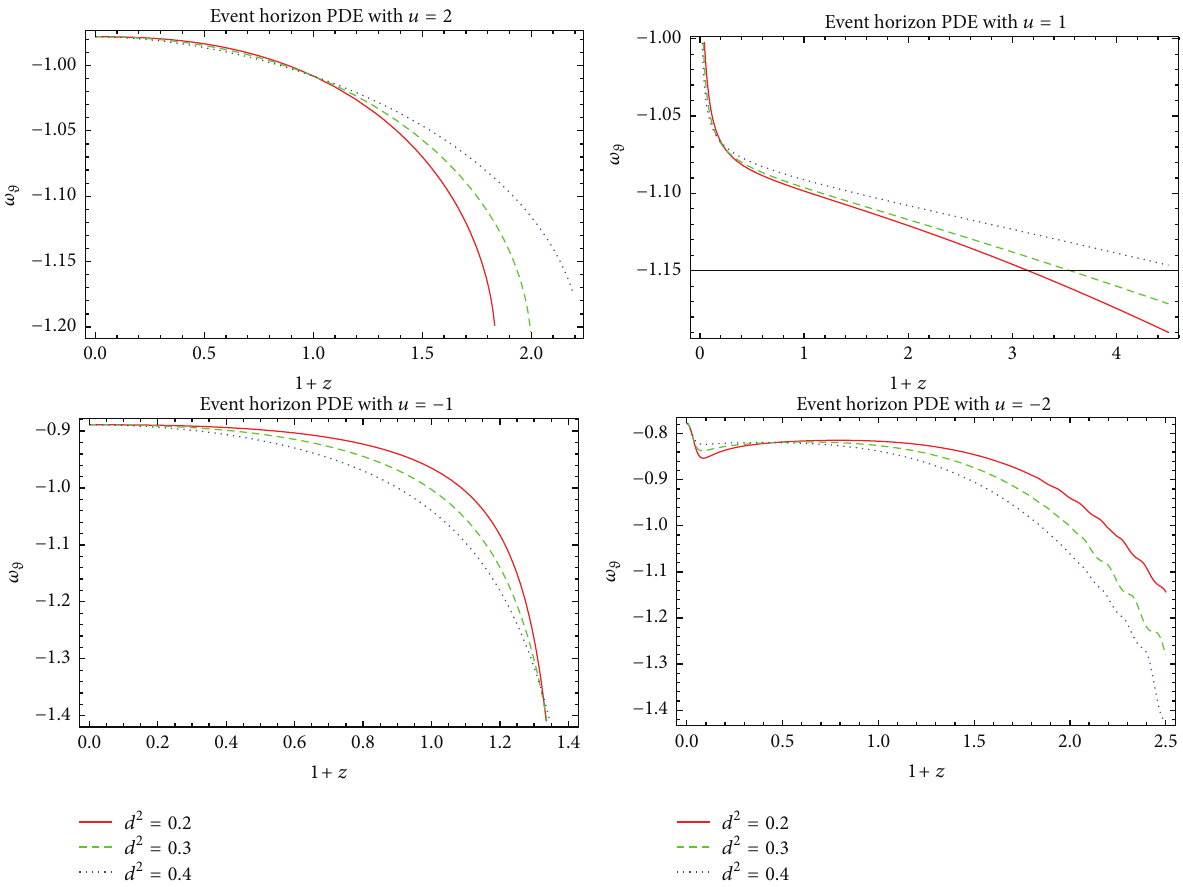
Figure 4: Plots of 𝜔 𝜗 versus 1 + 𝑧 for Hubble horizon PDE model in dynamical Chern-Simons gravity with 𝑢 = 2, 1,−1, −2 .